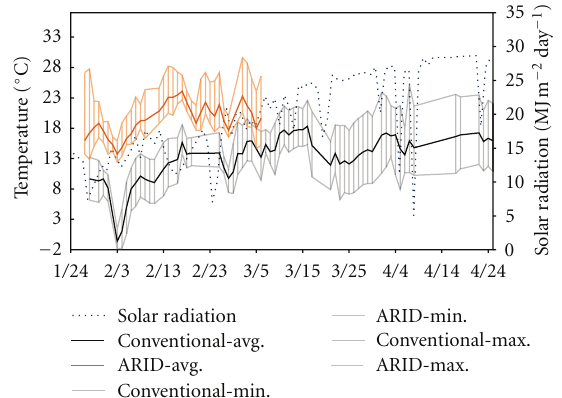
Figure 3: Daily ARID pond and conventional raceway water temperature average, minimum, and maximum and daily solar radiation.